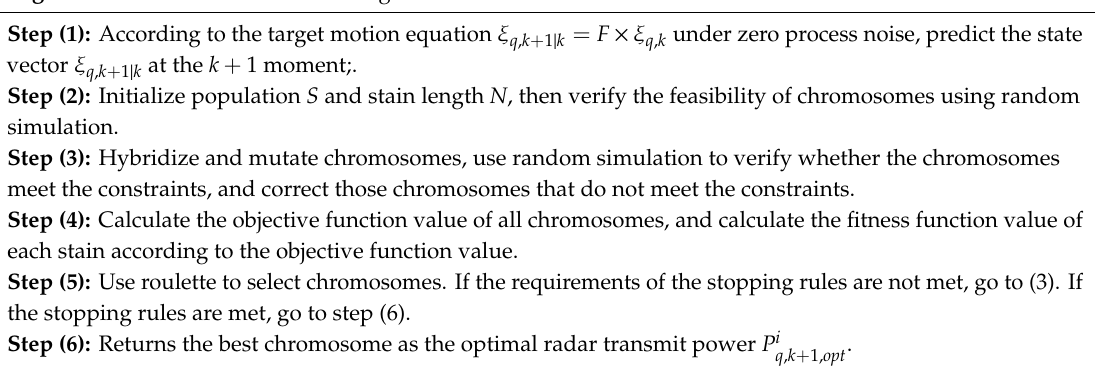
Algorithm 2. Stochastic simulation